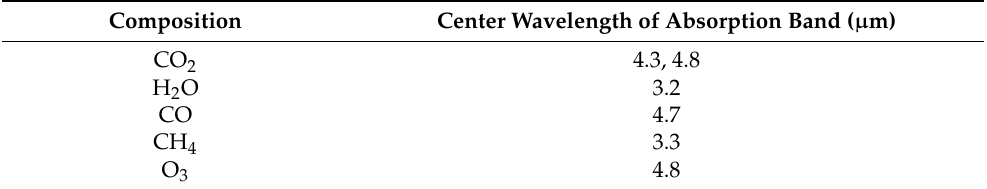
Table 2. Center wavelengths of infrared absorption bands for main atmospheric components at 3~5 µ m.